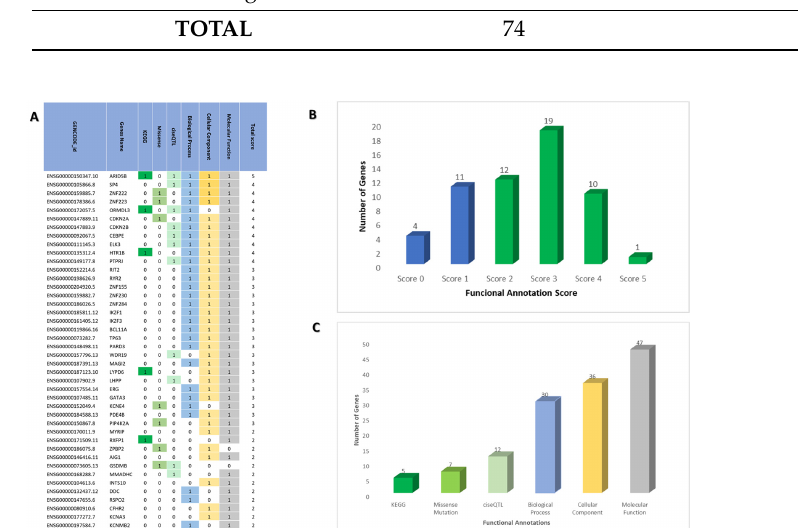
Figure 1. ( A ) List of genes with the score following application of functional annotations criteria. ( B ) The number of genes for each score following application of functional annotations criteria. ( C ) The number of genes overlapped with each functional annotations criterion. Most of the genes overlapped with the molecular function data.